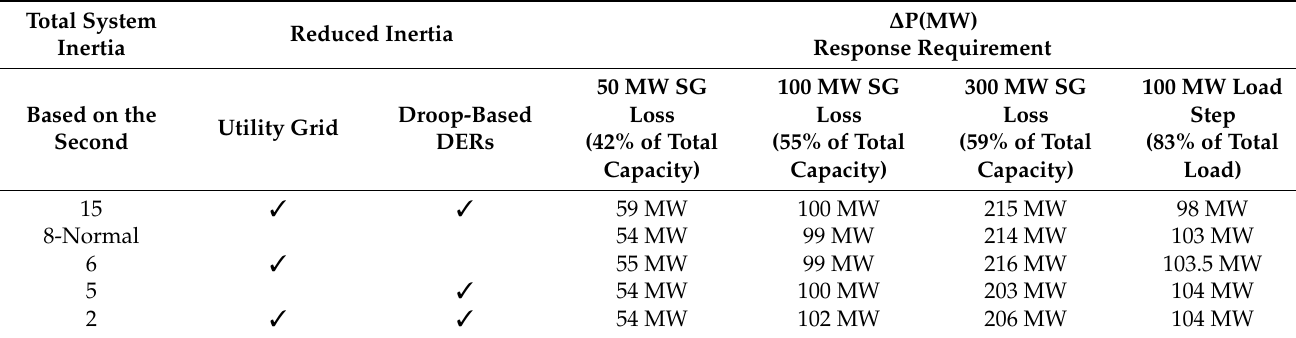
Table 6. Frequency Response Requirement for different values of inertia and generation loss.